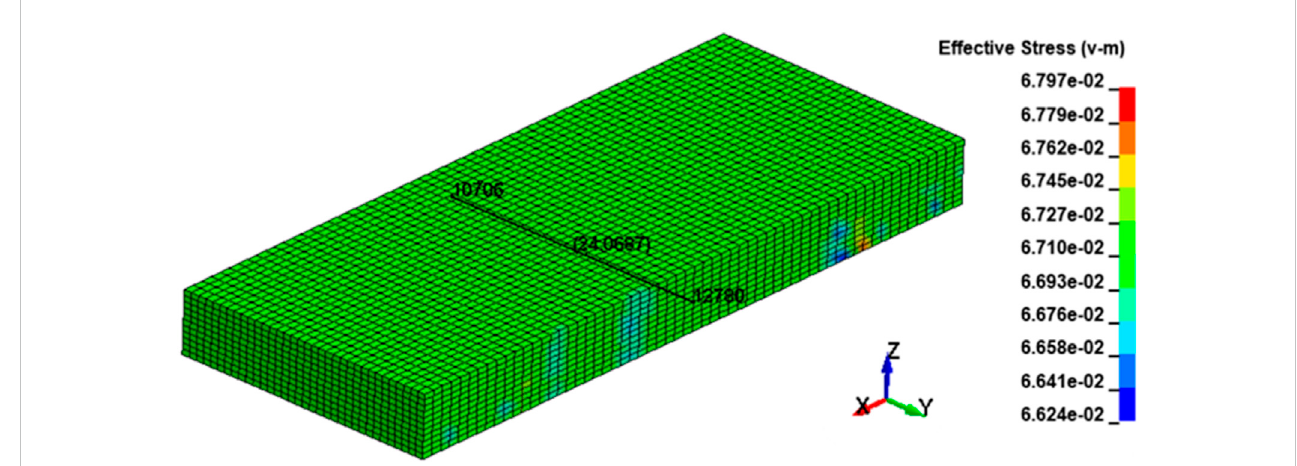
Battery ’ s von Mises stress on 10 mm deformation (all rigidwalls and impactor hidden).